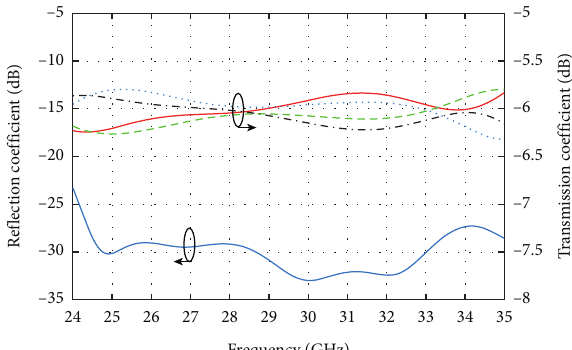
Figure 5: Simulated reflection and transmission coefficients of the sequential feeding